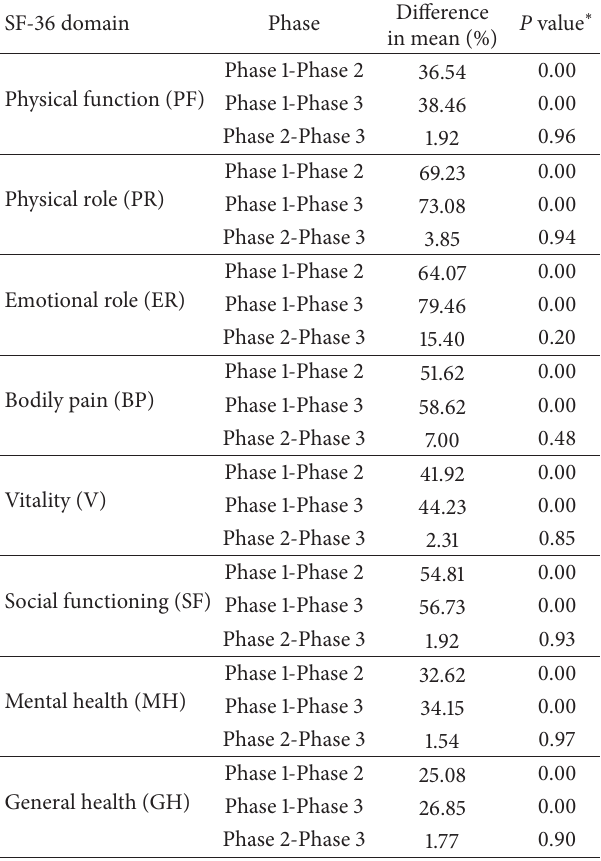
Table 2: Analysis of SF-36